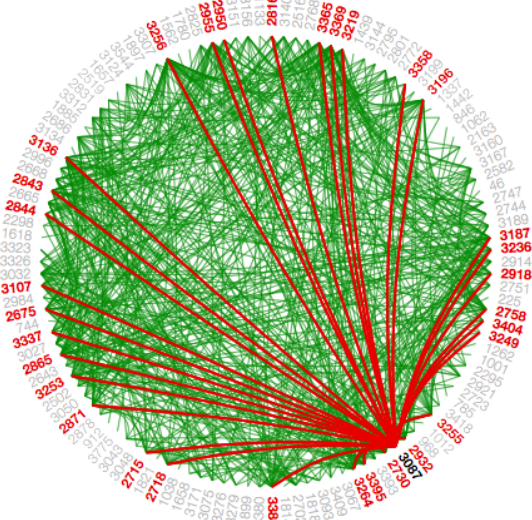
Figure A11. Demonstration of a mouse-hover interaction in hierarchical edge bundling visualization technique, in order to show the number of connections a circle has to the other circles.